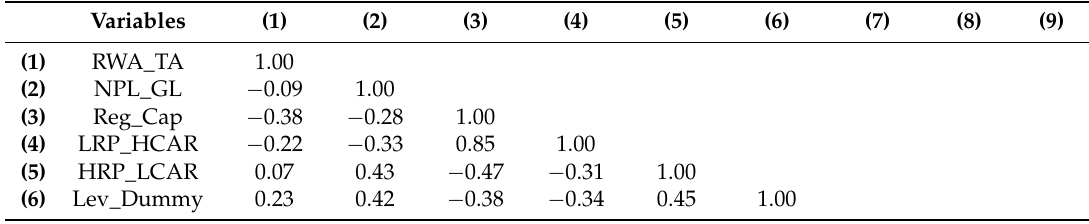
Table 2. Correlation matrix.